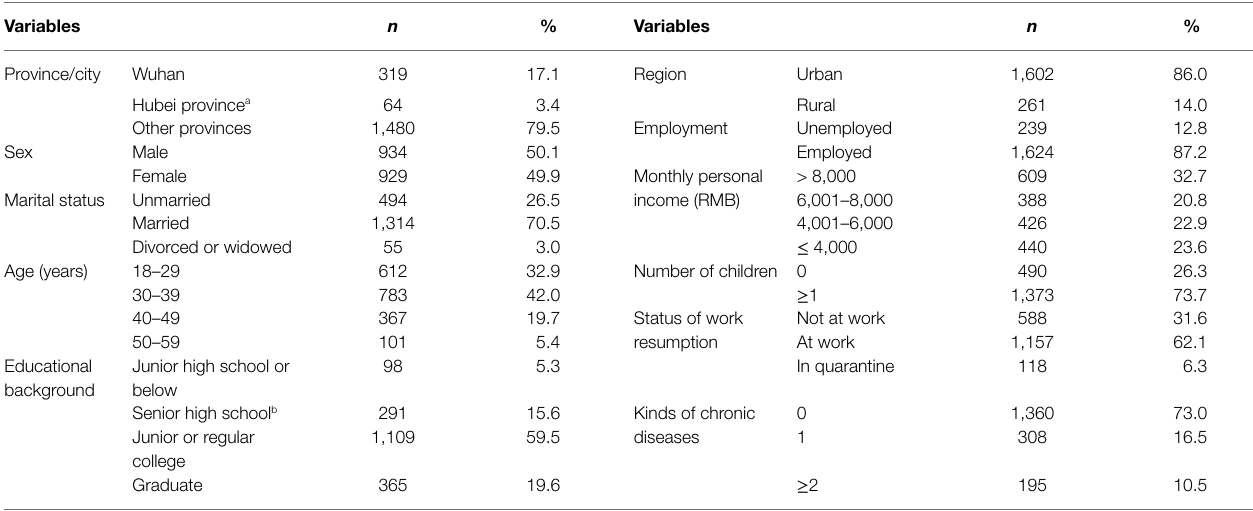
TABLE 1 | Personal and family characteristics of 1,863 participants.